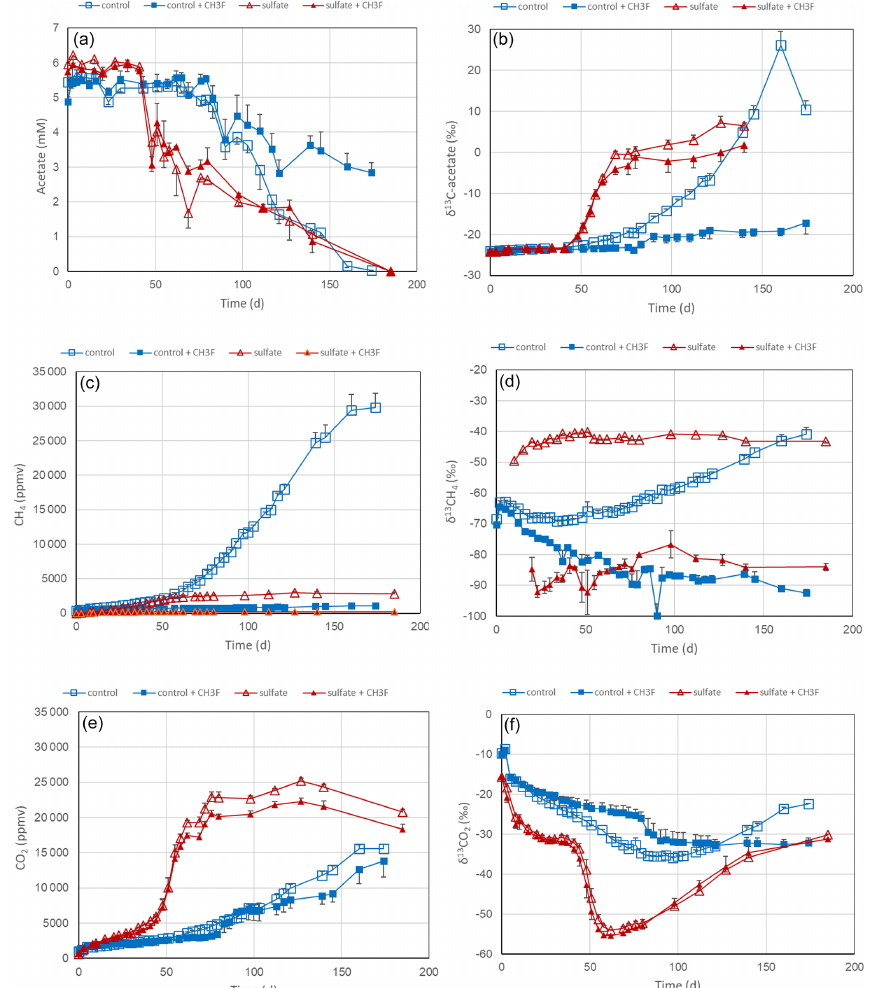
Figure 6. Acetate conversion to CH 4 and CO 2 in phosphate-buffered (pH 7.0) suspensions of sediment from the northeastern basin of Lake Fuchskuhle without additions (control), with CH 3 F, with gypsum (preincubation and experiment), and with gypsum (preincubation and experiment) and CH 3 F. The panels show the temporal change of (a) concentrations of acetate, (b) δ 13 C of acetate, (c) partial pressures